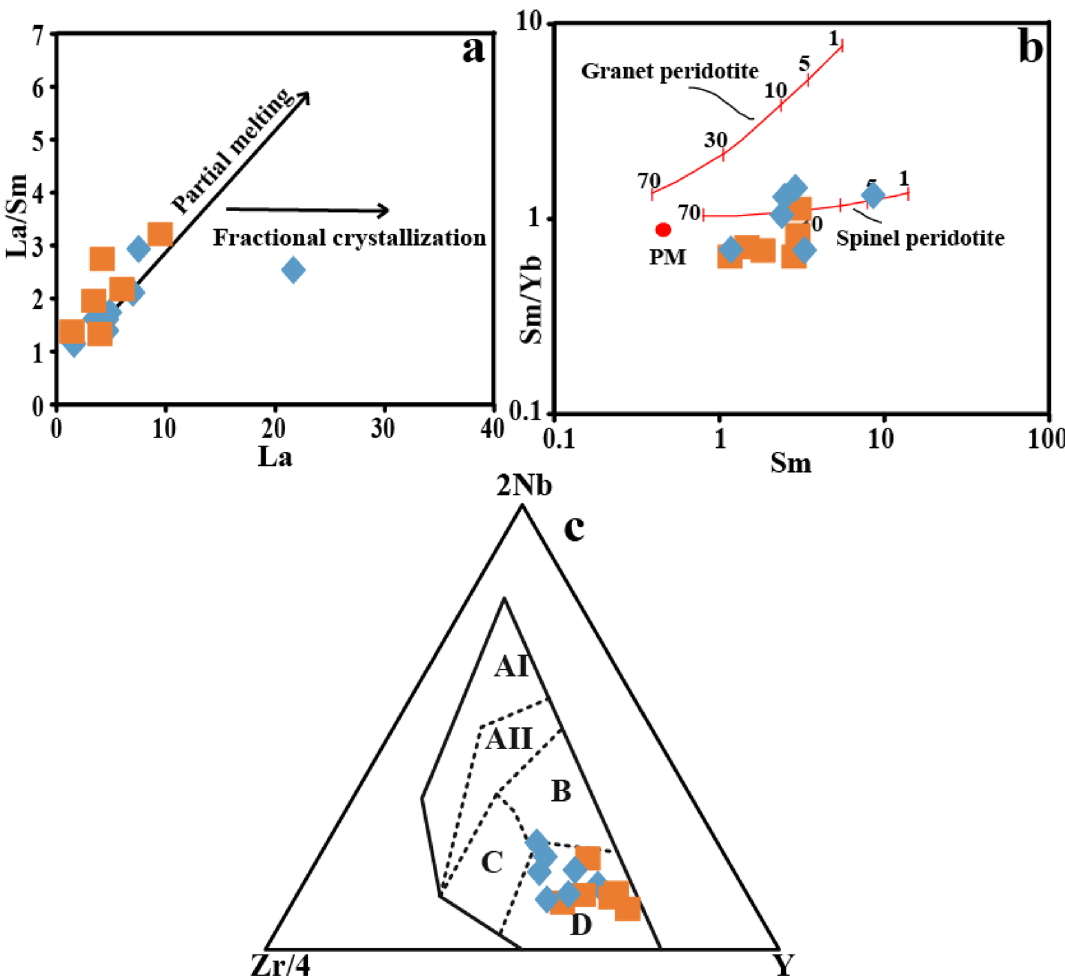
studied rocks and c Zr/4-2Nb-Y triangular diagram of [90]) showing the meta-mafics plotting in the field of N-MORB. Symbols are the same as in Fig.